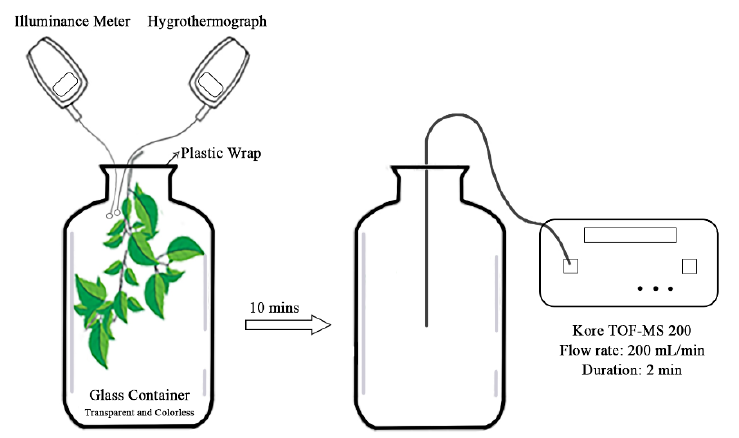
Figure 2. Sampling and measurement of isoprene emission rate. TOF-MS = time of flight mass spectrometry.